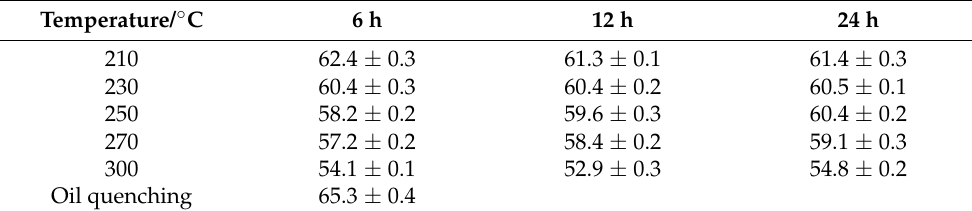
Table 5. Hardness values of different isothermal